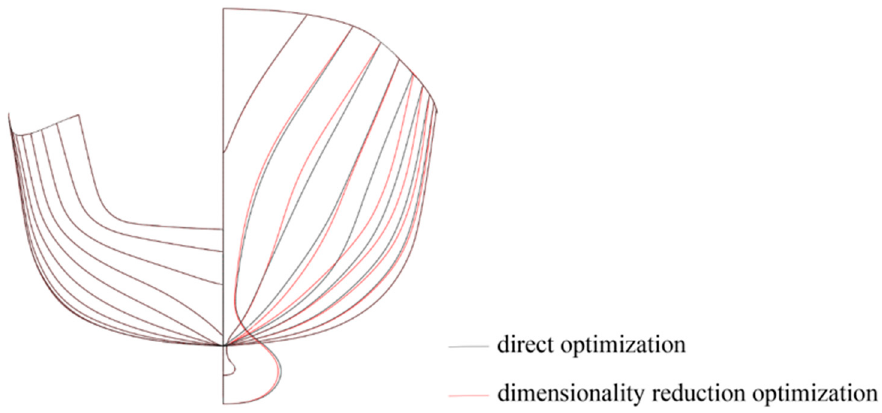
Figure 23. Comparison of body plan views of hull forms obtained by direct and dimensionality reduction optimizations.